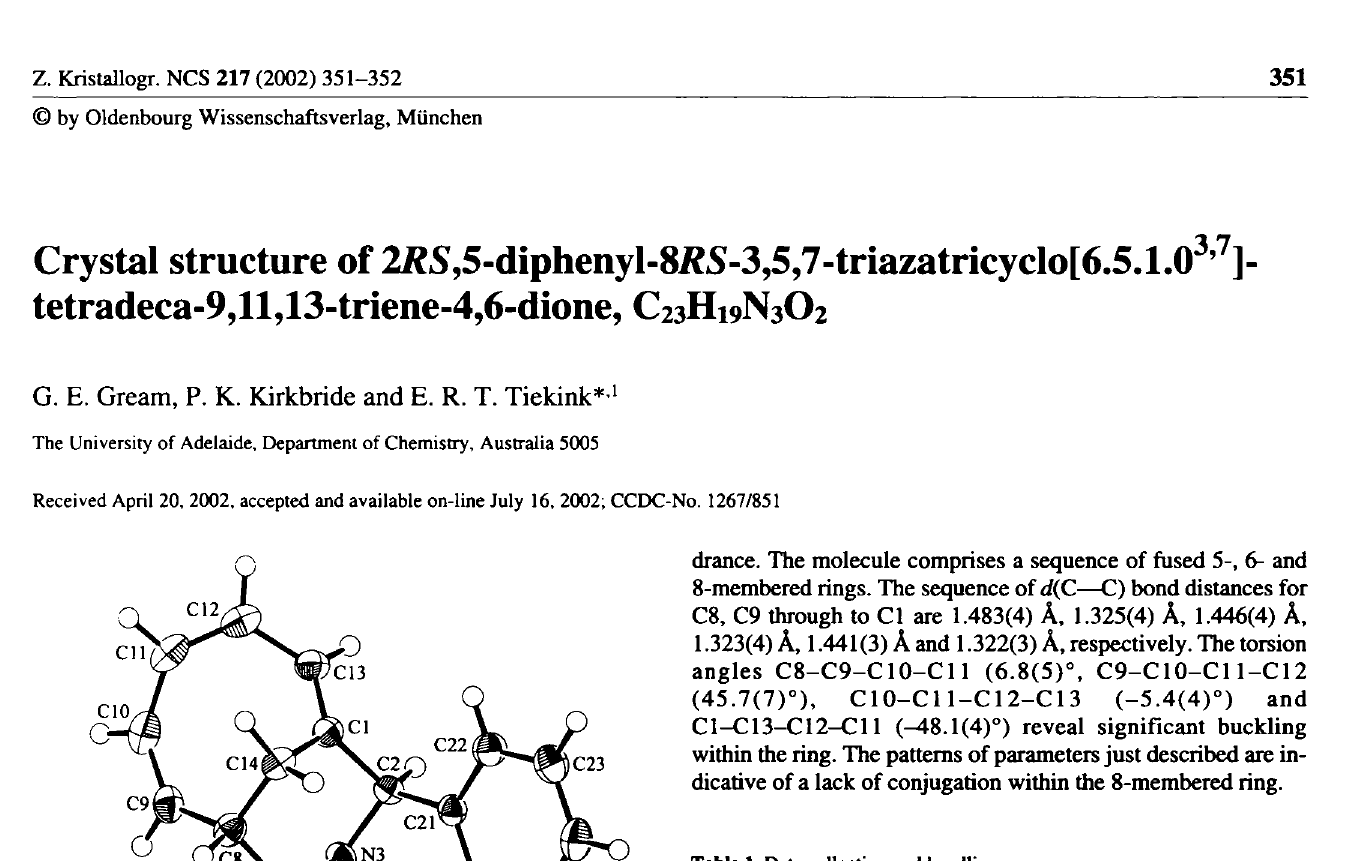
Table 2. Atomic coordinates and displacement parameters (in A 2